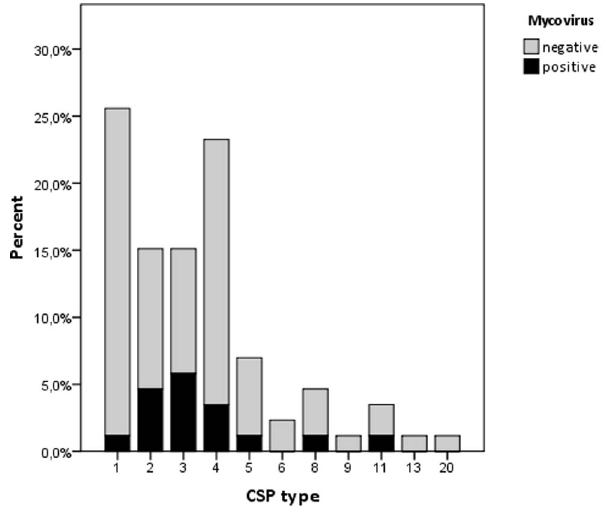
Figure 2. Frequency of CSP types among dsRNA infected and non-infected A.fumigatus strains. In 86 A. fumgiatus clinical isolates 11 CSP types were detected. DsRNA infection was observed in A. fumigatus CSP types t01, t02, t03, t04, t05, t08 and t011. No significant difference was observed between dsRNA infected A. fumigatus CSP types and non-infected A. fumigatus CSP types (Fisher exact, p